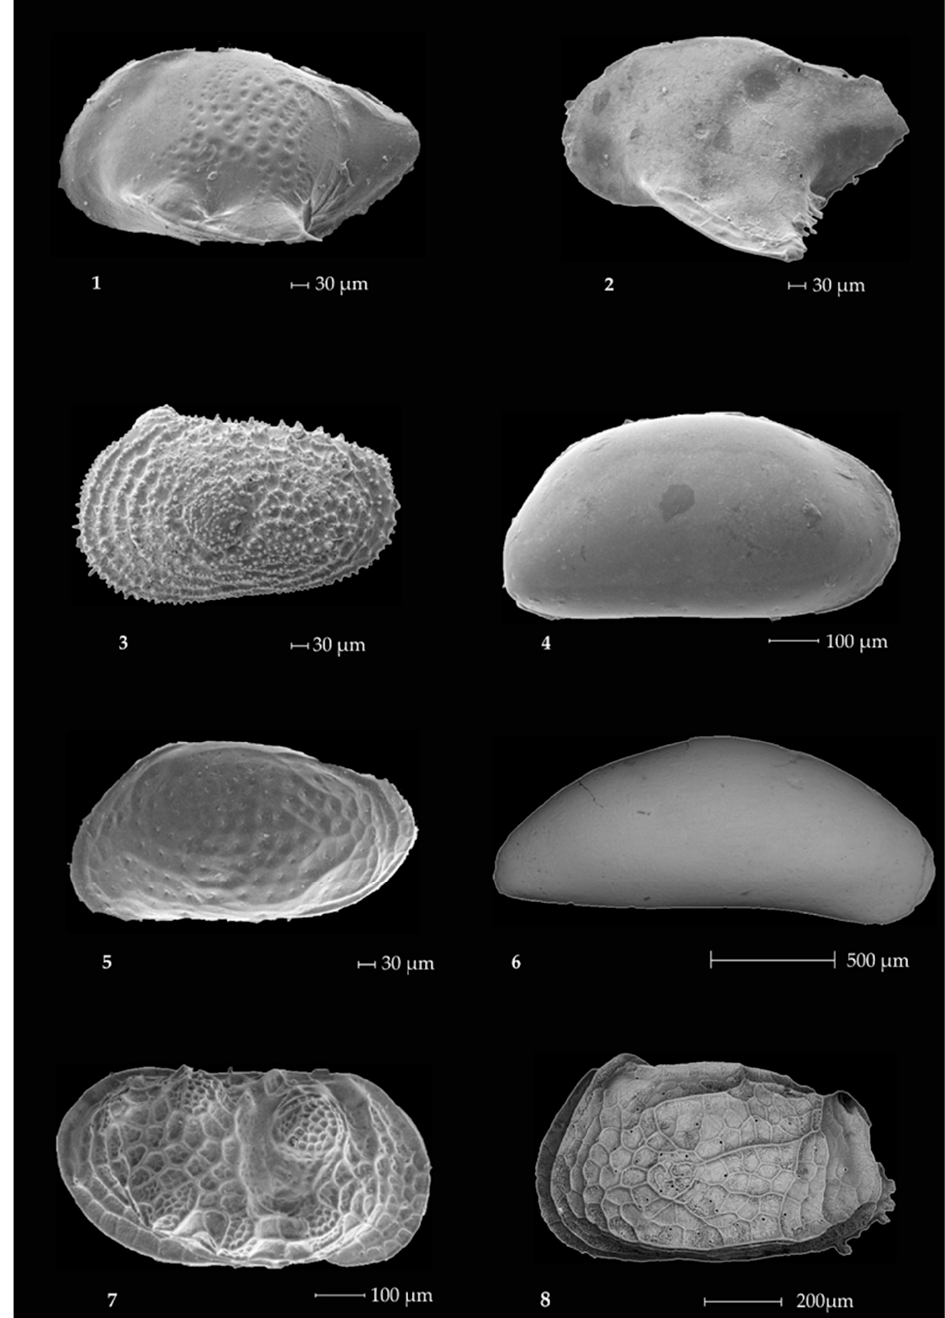
Figure A2. 1— Cytheropteron antarcticum . Lateral exterior view, left valve; 2— Cytheropteron sp. Lateral exterior view, left valve; 3— Echinocythereis sp. Lateral exterior view, left valve; 4— Krithe ( Austrokrithe ) magna . Lateral exterior view, right valve; 5— Loxoreticulatum fallax . Lateral exterior view, left valve; 6— Macropyxis similis . Lateral exterior view, right valve; 7— Nodoconcha minuta . Lateral exterior view, right valve; 8— Patagonacythere longiducta . Lateral exterior view, left valve.